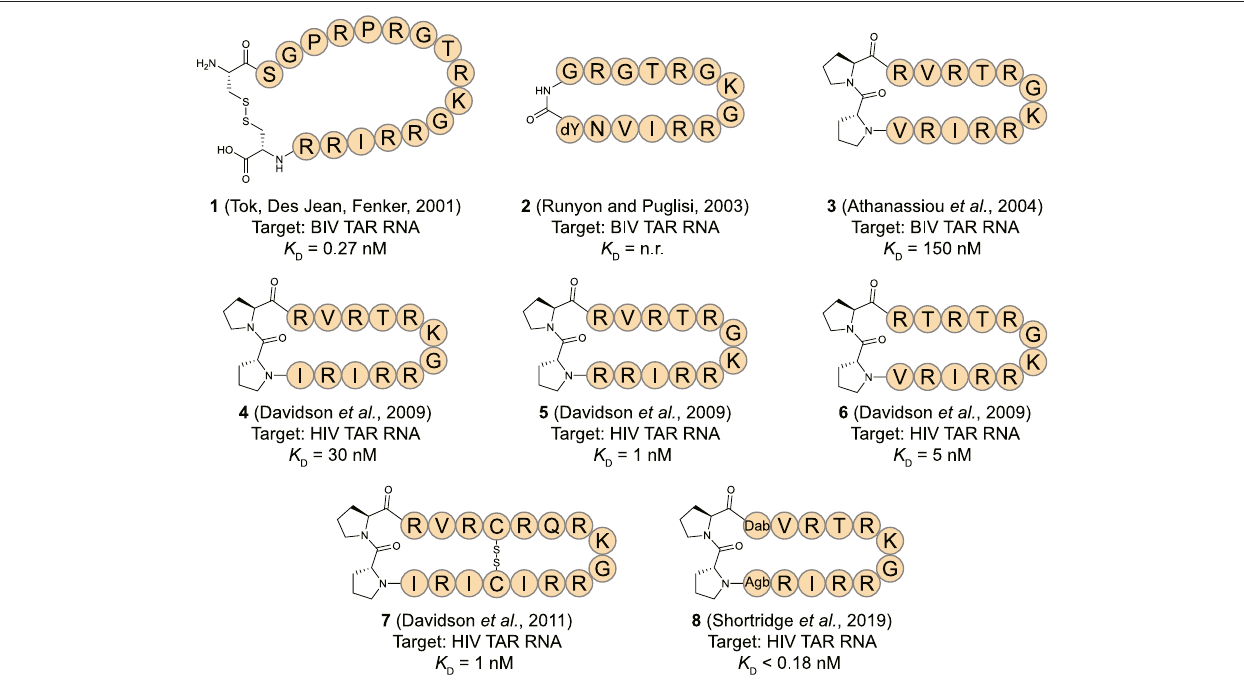
FIGURE 4 | Structures of HIV TAR RNA binding cyclic peptides derived from the BIV or HIV Tat proteins. Dab = L-2,4-diaminobutyric acid, Agb = L-2-amino-4- guanidinobutyric acid (norarginine). n. r. = not